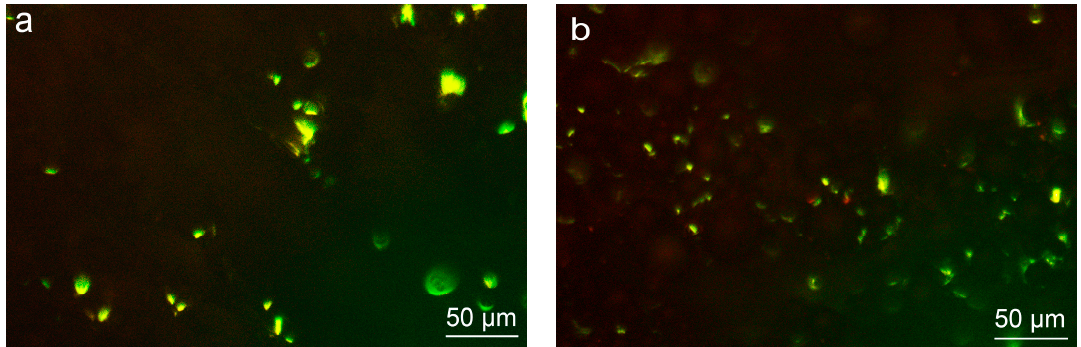
Figure 5. Cellular viability evaluation (CCK-8 assay) of MC3T3-E1 cells on different surface surfaces after one-day and five-day